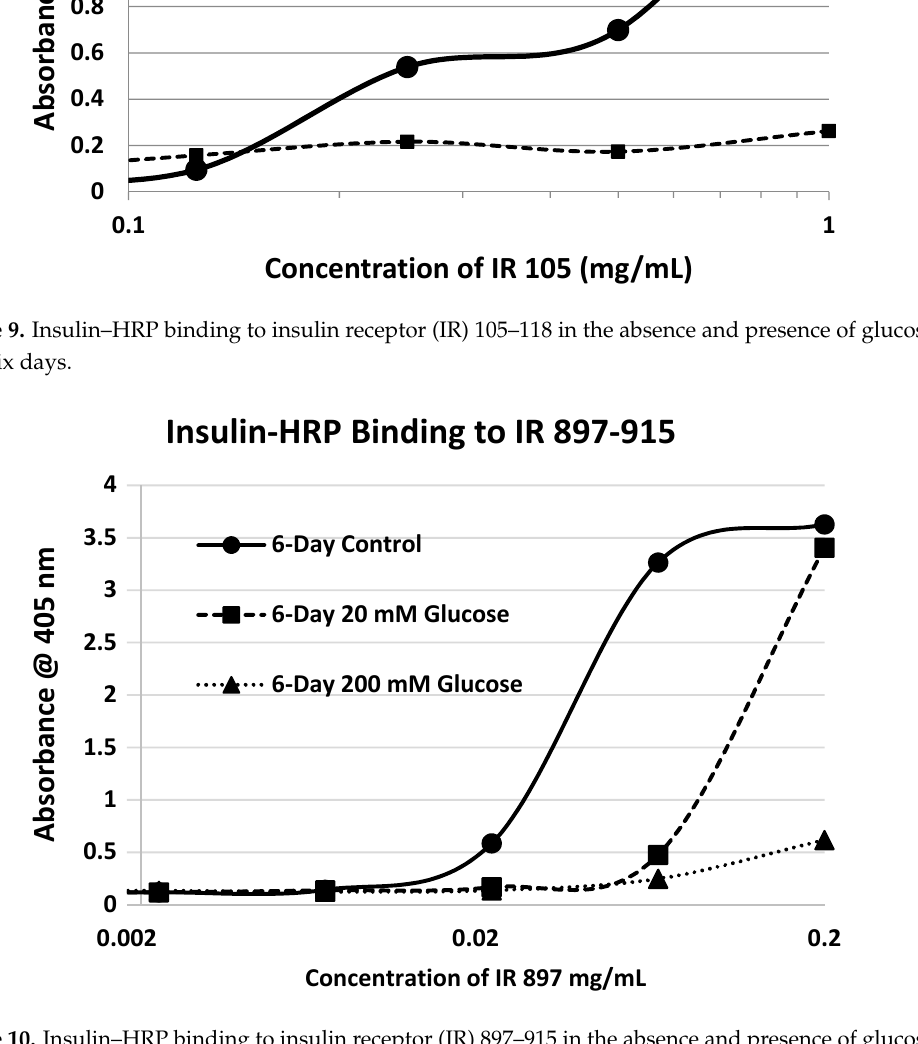
Figure 10. Insulin–HRP binding to insulin receptor (IR) 897–915 in the absence and presence of glucose over six days.